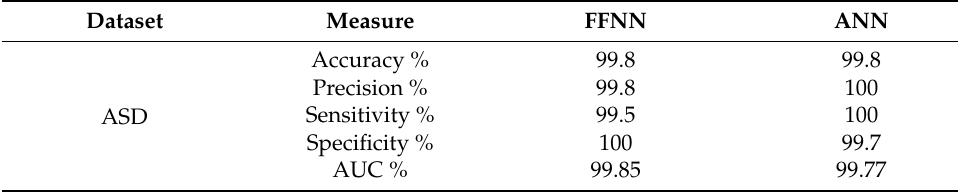
Table 4. Performance of FFNN and ANN algorithms on ASD dataset.